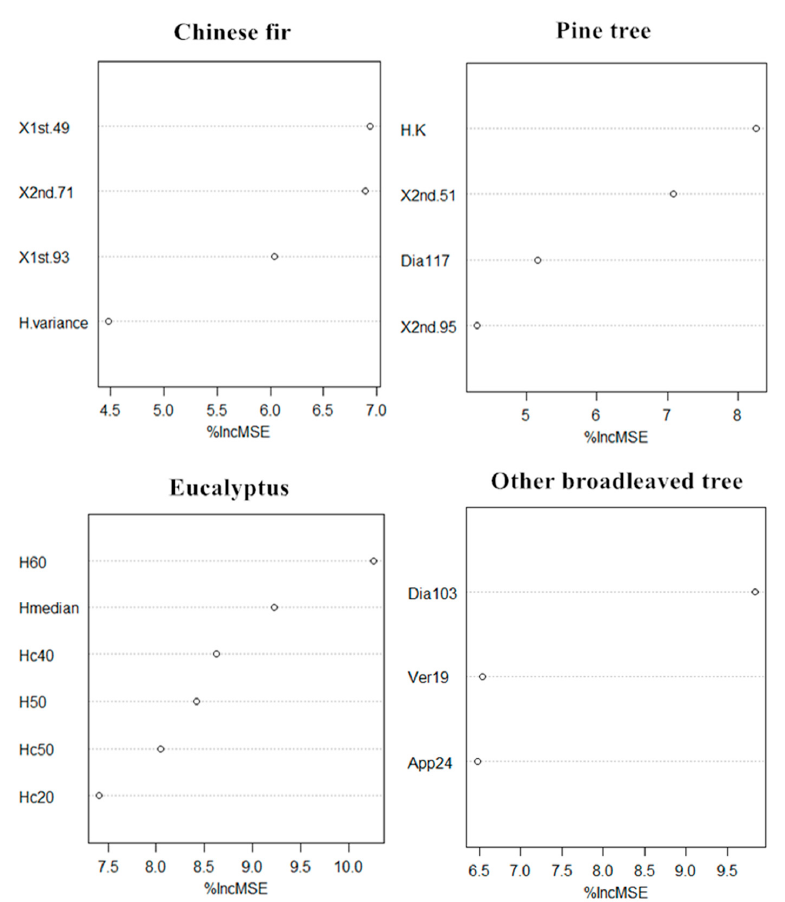
Figure 5. The feature importance ranking map after three-level screening of fused features.